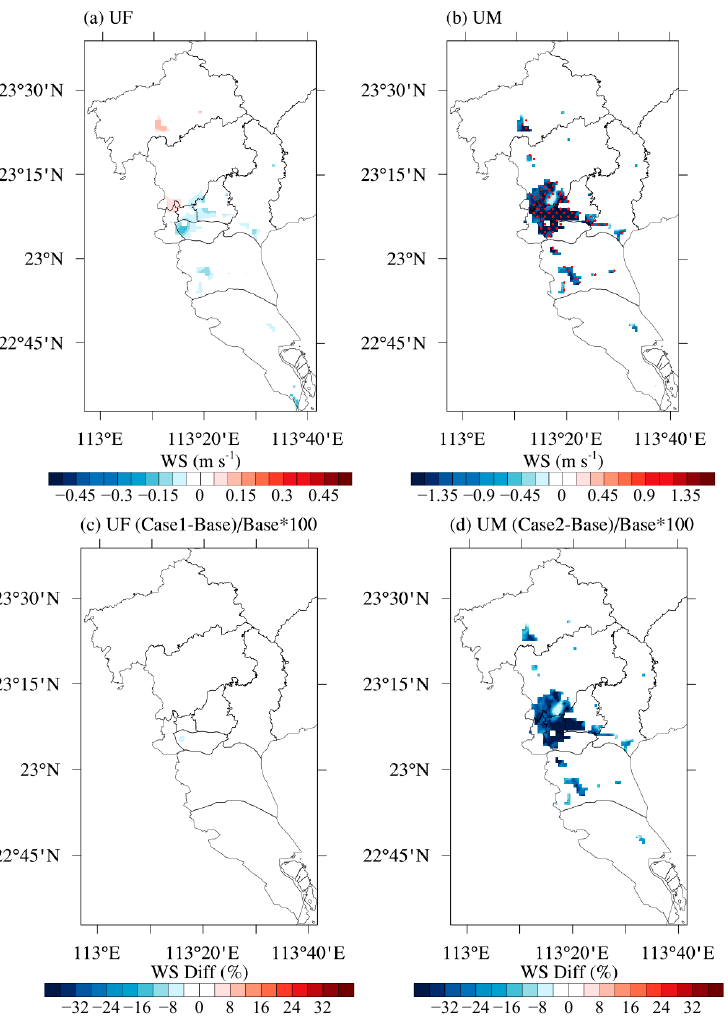
Figure 11. Impacts of the high-resolution UF and UM on the average 10 m wind speed (WS) in the urban underlying surface of Guangzhou. Here, the impacts of UF/UM were calculated by comparing the simulated hourly WS values for 10 days (from 1 to 10 November) in two experiments and then averaging the result. ( a ) UF (Case 1—Base) impact; ( b ) UM (Case 2—Base) impact; ( c ) percentage change due to UF (Case 1—Base)/Base × 100; ( d ) percentage change due to UM (Case 2—Base)/Base × 100. In ( a , b ), statistically significant changes above the 99% confidence level are marked with red dots.